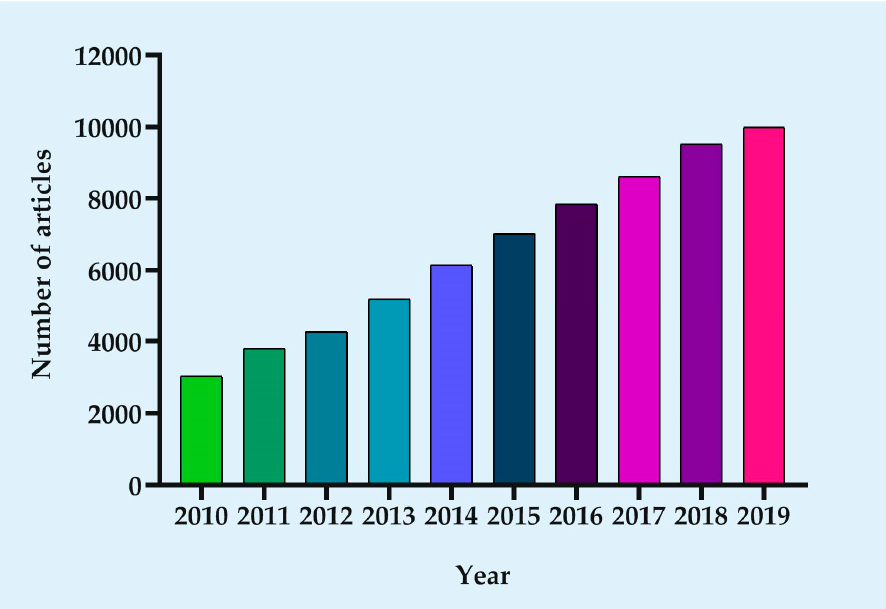
Figure 1. Growth in the number of published articles. Since the focus of this paper is on nanocarrier-based drug delivery for cancer therapy, the following parameters were searched in PubMed: ((cancer) OR (tumor)) AND ((((((((((((((nanoparticle) OR (nanocarrier)) OR (liposome)) OR (micelles)) OR (dendrimers)) OR (Niosomes)) OR (nanoemulsions)) OR (nanocrystals)) OR (Exosomes)) OR (quantum dots)) OR (carbon nanotubes)) OR (nanodiamonds)) OR (nanocapsules)) OR (hybrid nanomedicine)).